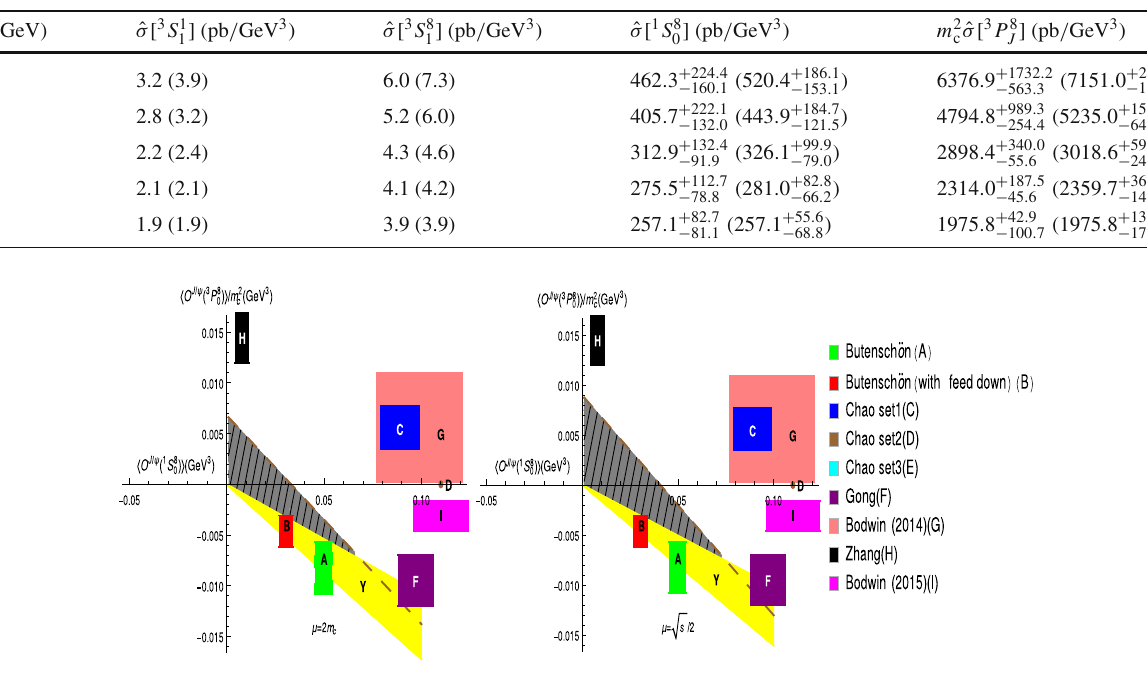
gray shaded region presents the combined constraints to LDMEs. For comparison, the LDMEs extracted from the fit to the hadron colliders data in Table 1 are also shown and correspond to areas labeled A to I . The LDMEs of “Chao set3” which exceed the display range are not given in the